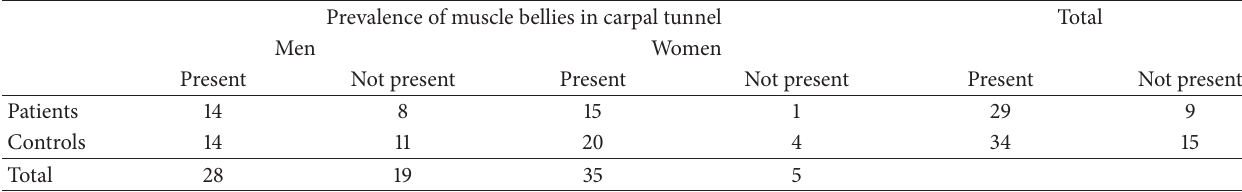
Table 2: Prevalence and gender distribution of muscles in patients and controls.